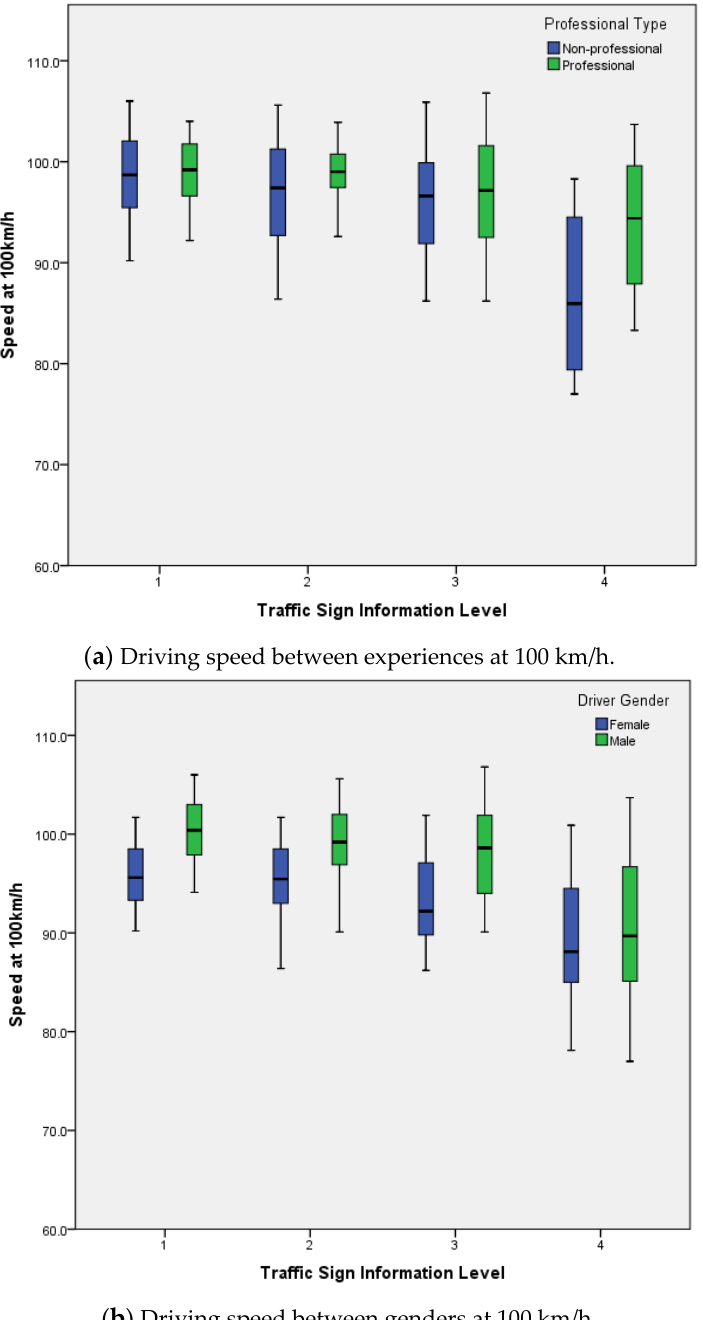
Figure 8. Driving speed at different sign information levels.